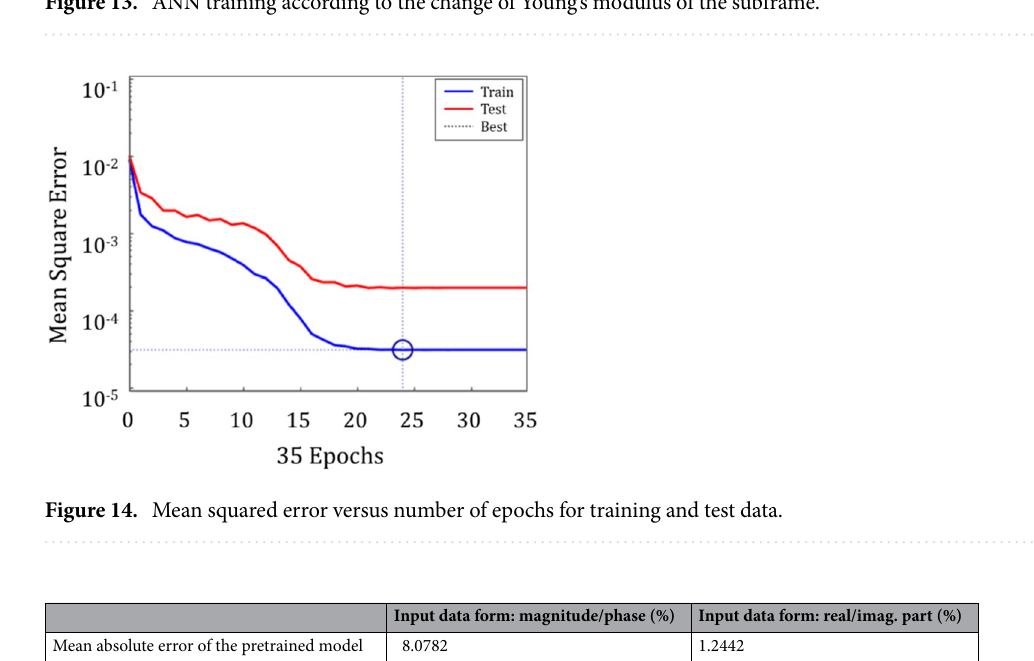
Figure 13. ANN training according to the change of Young’s modulus of the subframe.